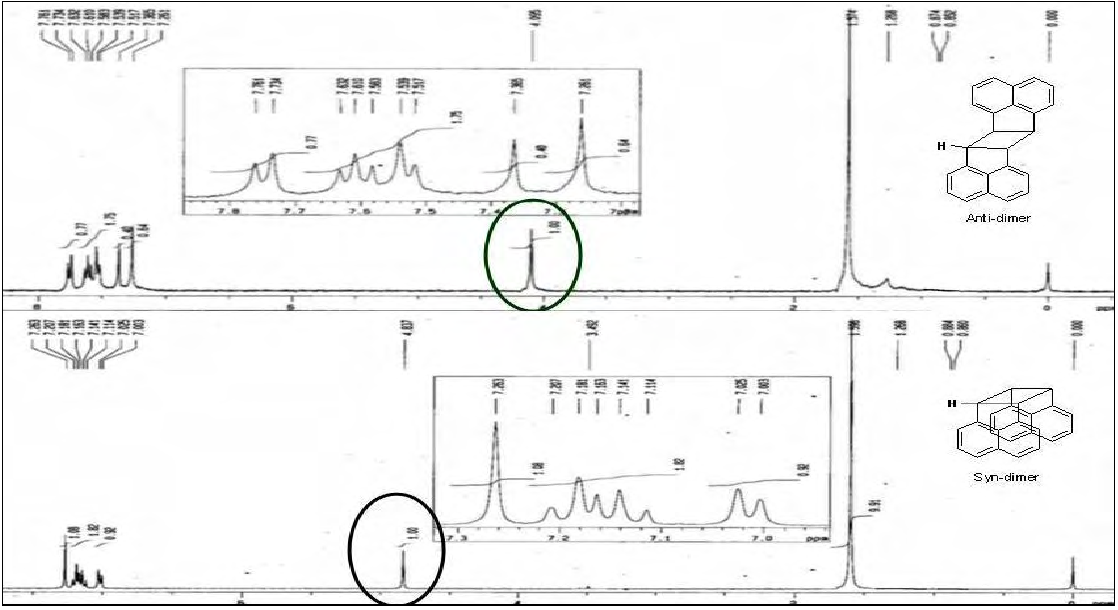
Figure 1 : 1 H-NMR spectrum of syn (bottom) and anti (top) dimers of ACN obtained in CDCl . A cyclobutane-H signal (circle, δ value for syn dimer 4.837; for anti dimer 4.095) 3 was monitored for analyzing the isomeric ratios.